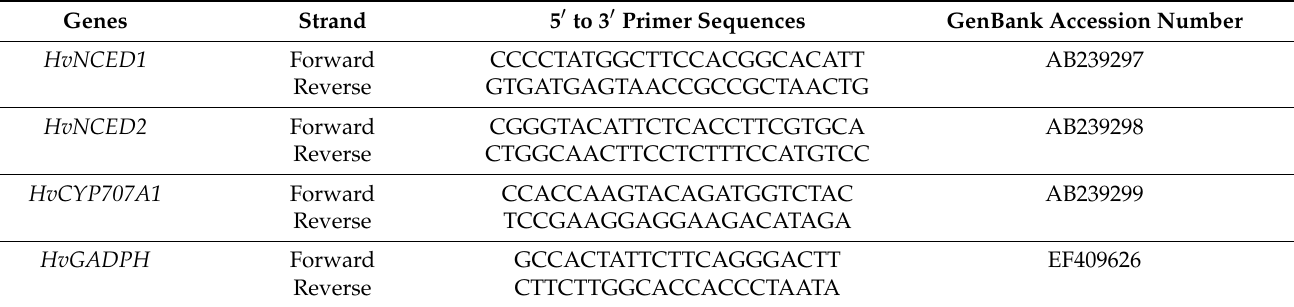
Table 1. Sequences of primers used for qRT-PCR (annealing temperature 60 ◦ C). Genes Strand 5 (cid:48) to 3 (cid:48) Primer Sequences GenBank Accession